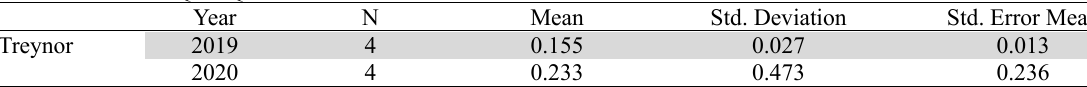
T Test Results on LQ 45 Quadrimester 1 Shares in 2019 and 2020